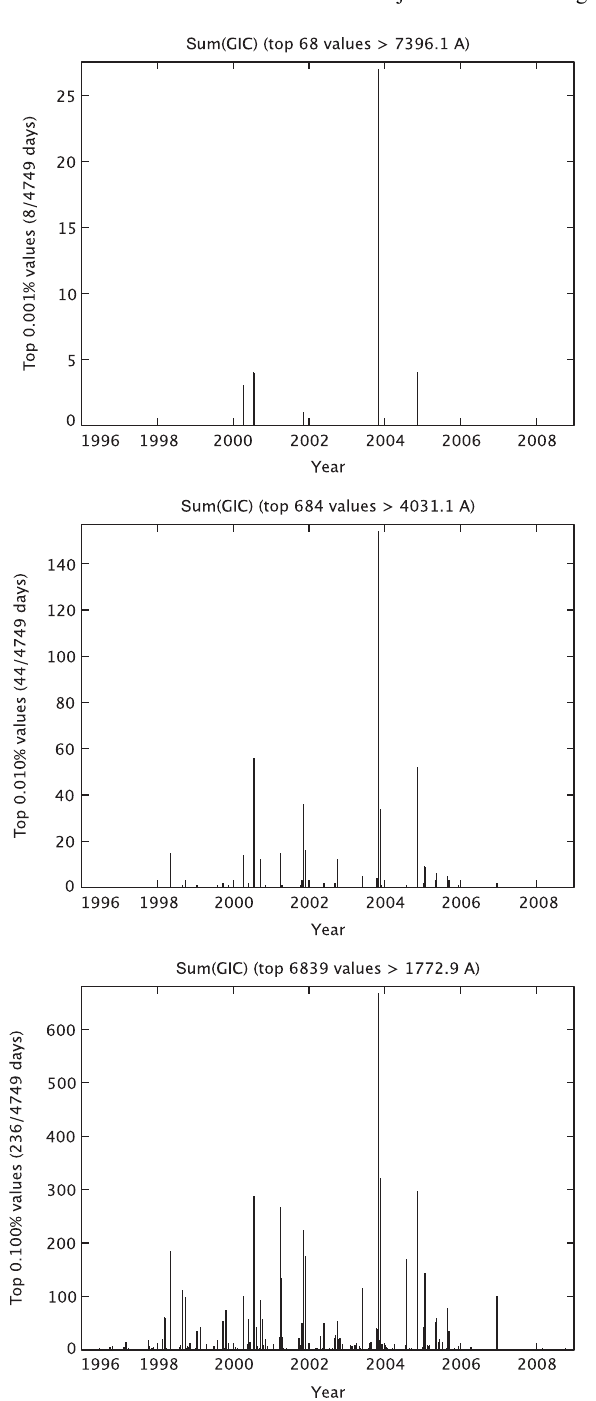
Fig. 6. Days of large GIC as ranked by the sum of absolute GIC of all nodes in the European high-voltage grid (number of large 1-min values shown). From top to bottom panel: occurrence of the top 0.001%, 0.01%, 0.1% of all